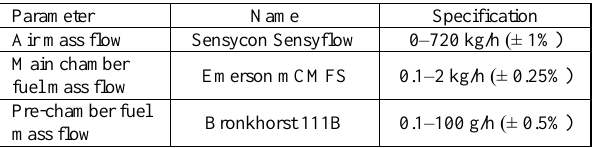
Table 2. Mass flow meters technical data